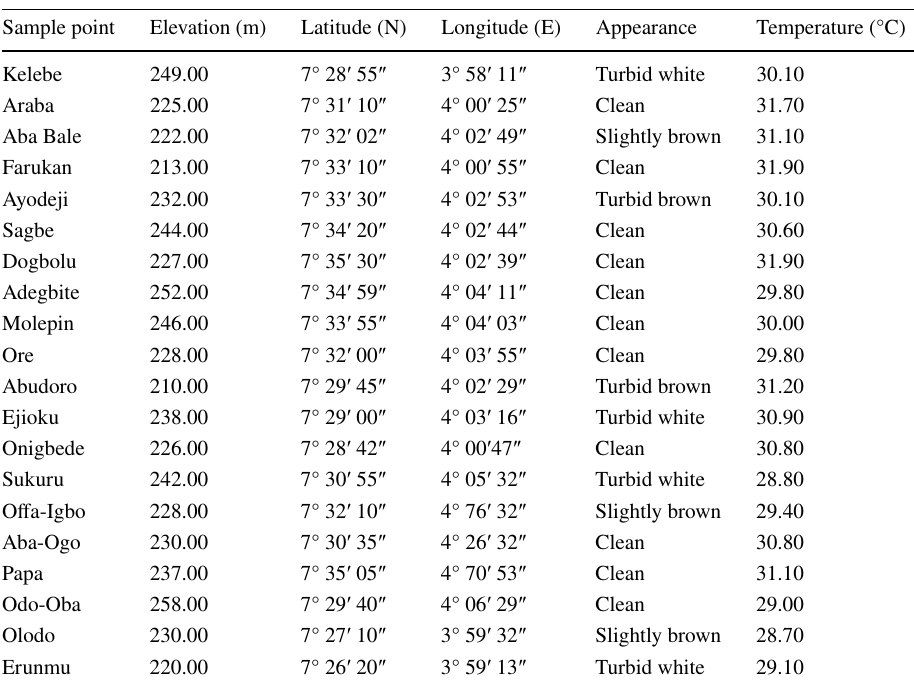
properties of the groundwater samples measured in